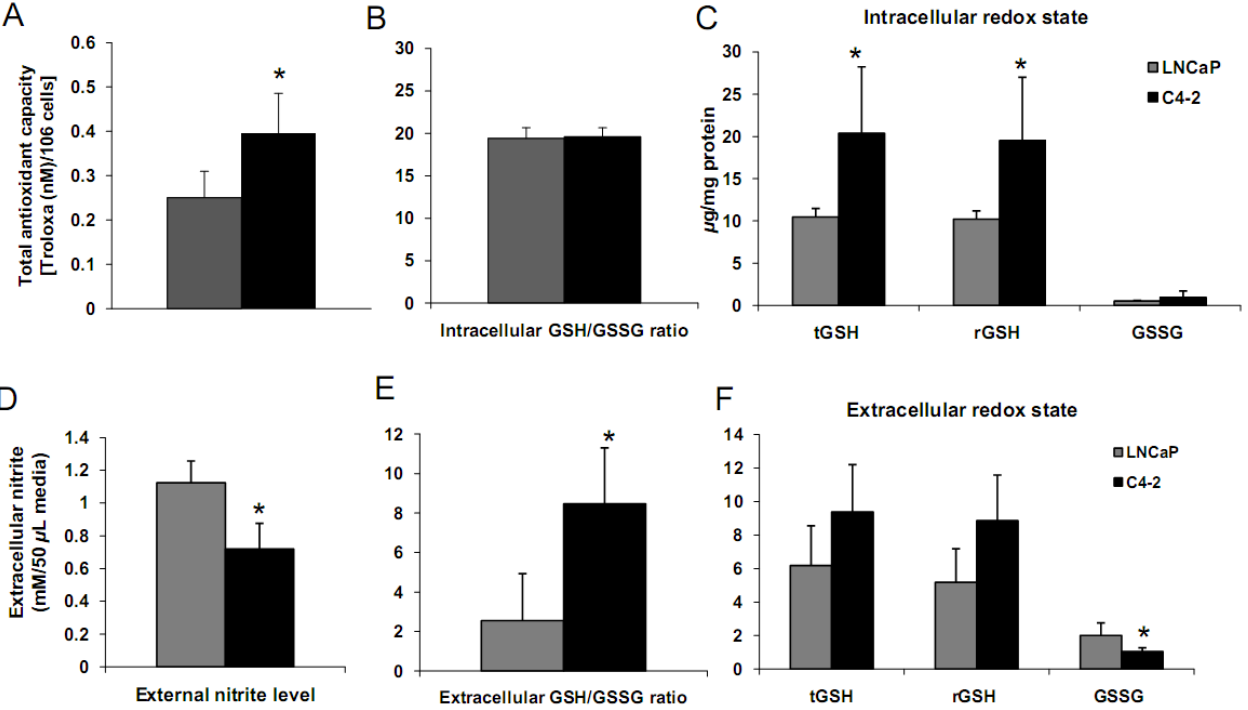
Figure 9. Analysis of redox states in LNCaP vs . LNCaP-C4-2 cells. Cells were cultured in RPMI without serum for 24 h before cells and conditioned media were collected for further analysis. ( A ) Total antioxidant capacity; ( B ) Intracellular GSH/GSSG ratio; ( C ) Intracellular GSH and GSSG levels; ( D ) Extracellular nitrite levels. Nitrite levels in conditioned media were analyzed based on the Griess reagent system; ( E ) Extracellular GSH/GSSG ratio; ( F ) Extracellular GSH and GSSG levels. * P-value ≤ 0.05 when